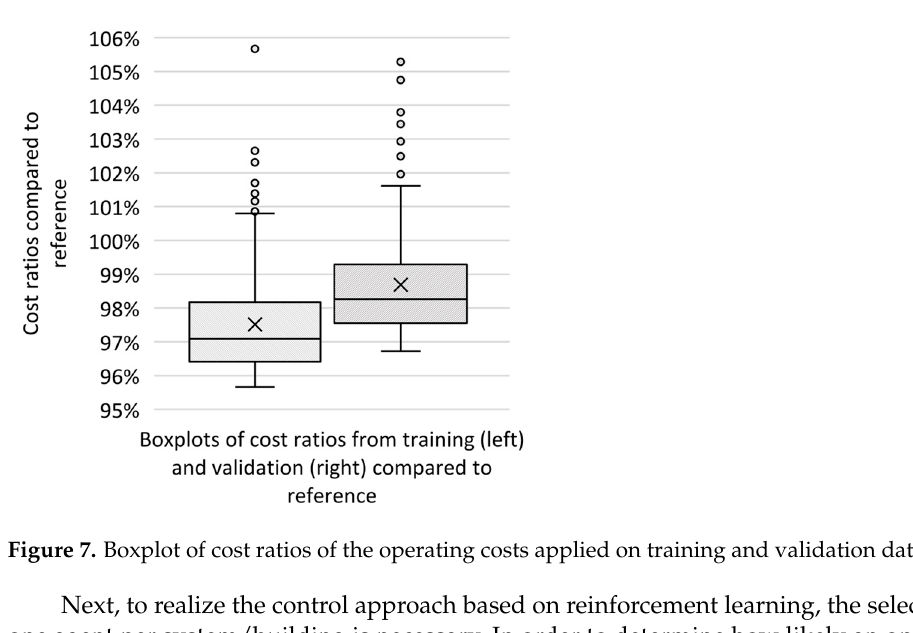
Figure 7. Boxplot of cost ratios of the operating costs applied on training and validation dataset.